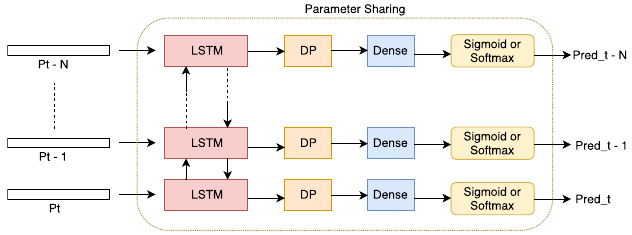
Figure 5. Bidirectional LSTM with a dropout and dense